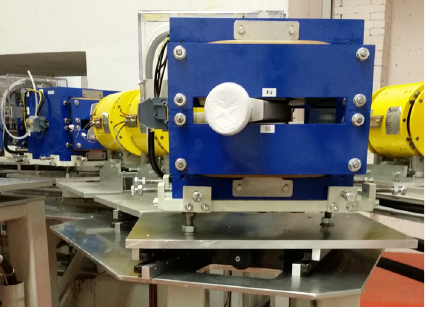
FIG. 4. Detailed view of one path length adjustment system. The magnets are installed on moveable tables sitting on ball bearing slides driven by stepper